Question: In one sentence, what is this figure communicating?
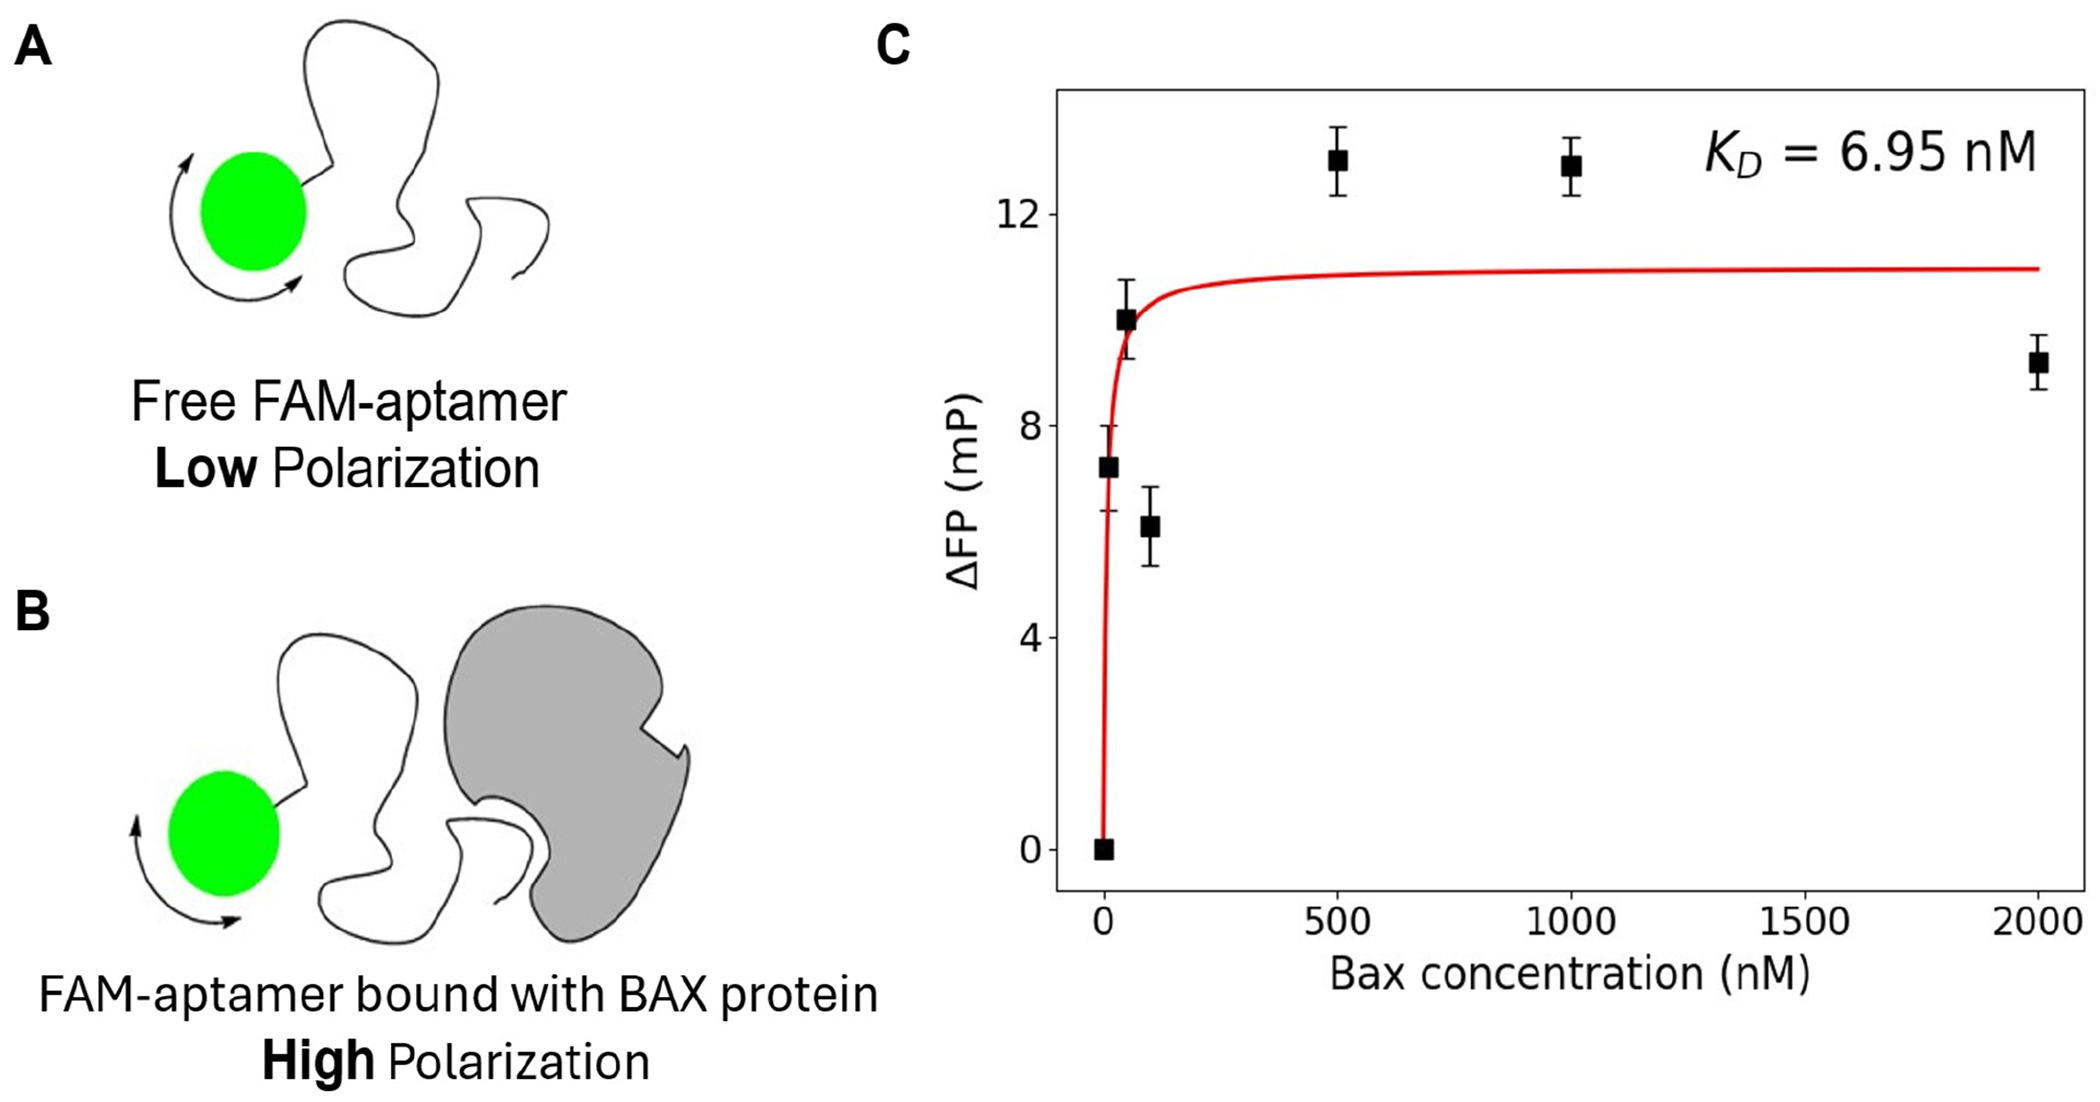
Answer: Fluorescence Polarization Assay. The design and principle of the assay are shown in ( A ) for free fluorescent aptamers and ( B ) protein target-bound fluorescent aptamer. ( C ) Titration curve of Apt3 for K D quantification (error bars represent standard errors from three independent measurements).